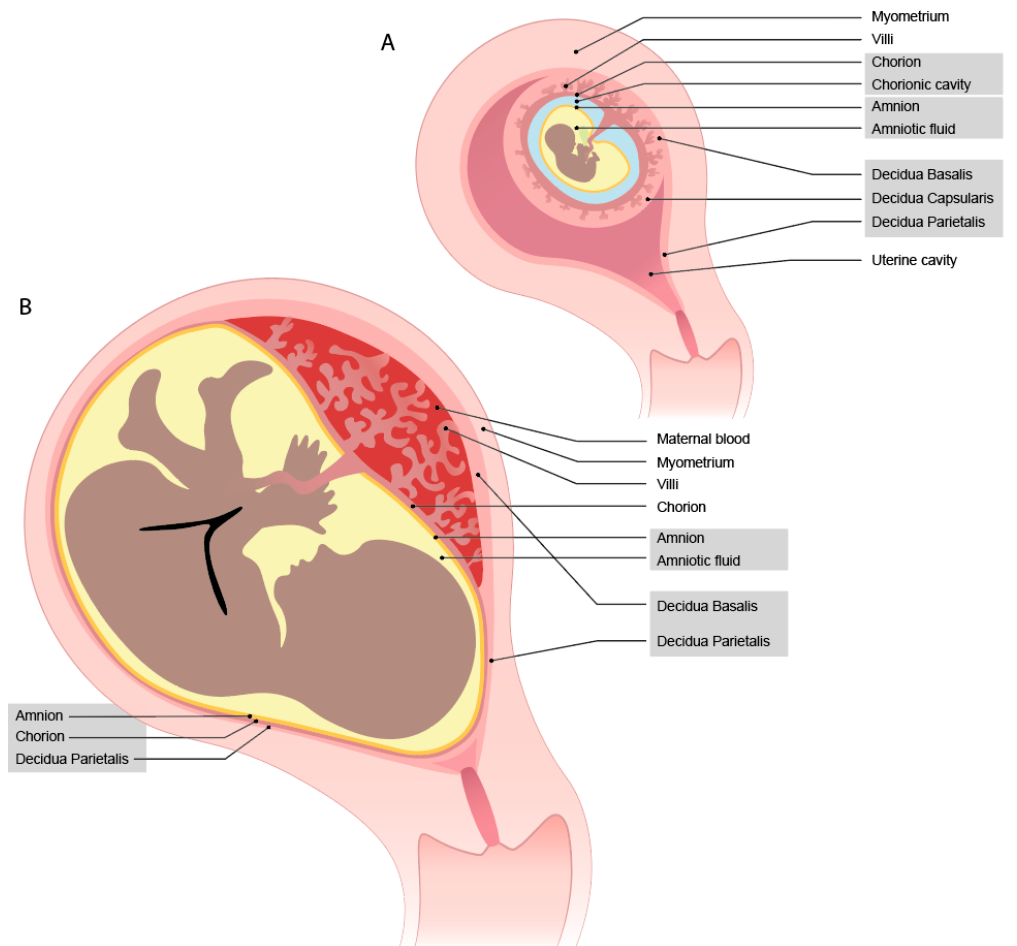
Figure 1. Overview of developmental changes of the maternal-fetal interaction sites from (A) first trimester to (B) term.